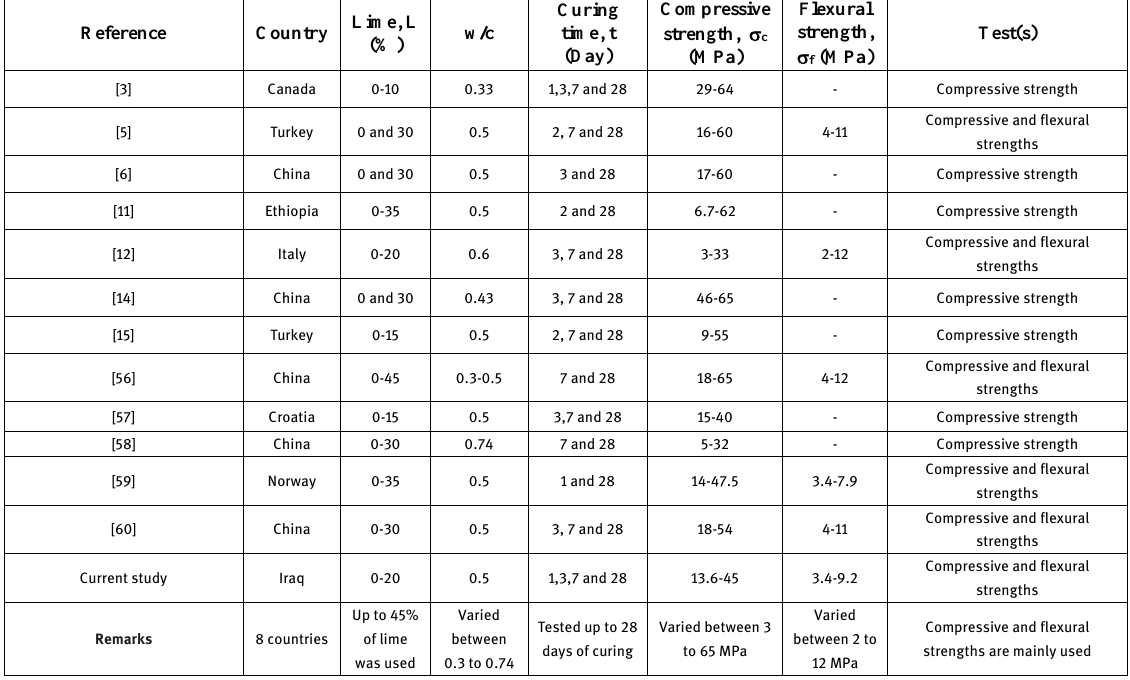
Table 1: Summary properties of cement mortar modified with lime